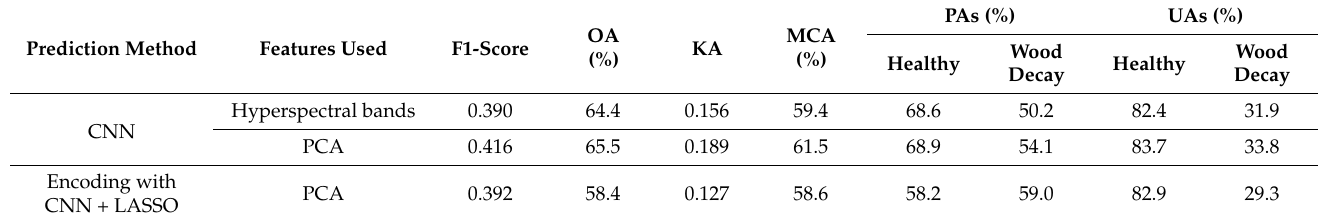
Table 3. Overall summary of the model performances with un-aggregated pixels for Dataset I.